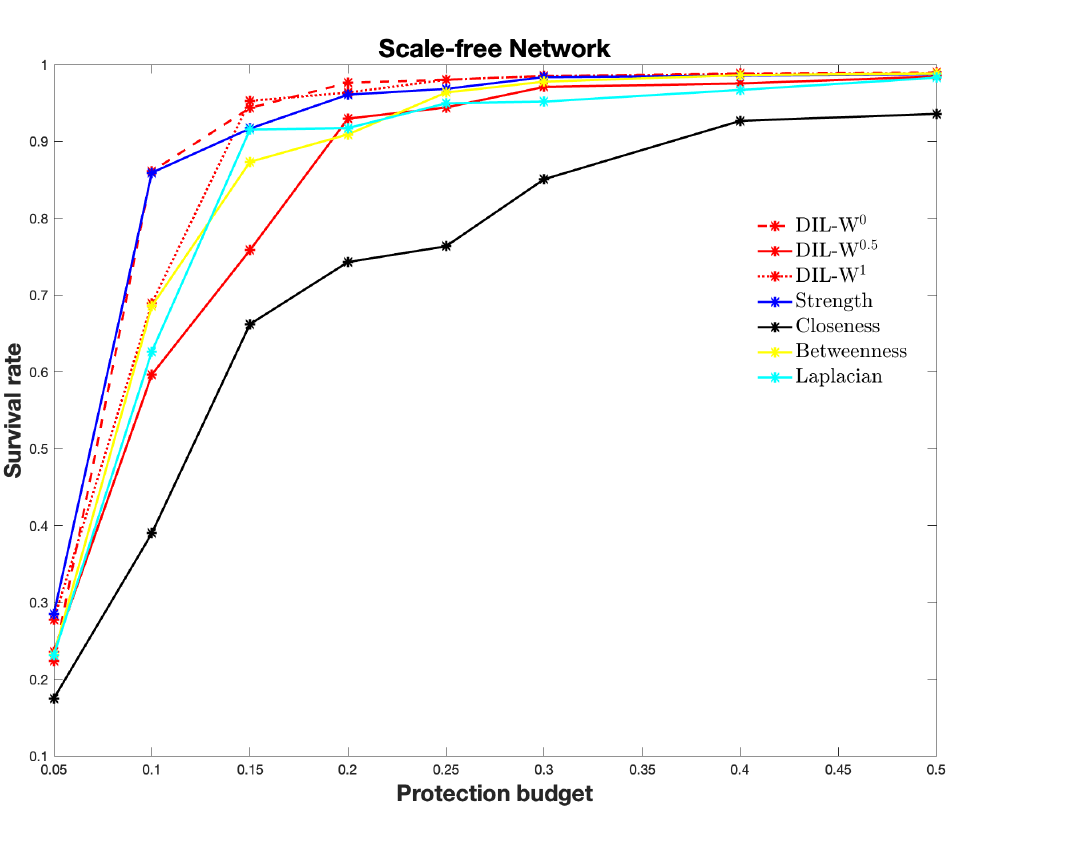
Figure 4. σ as a function of k on a Scale-free network with N = 100 and d =